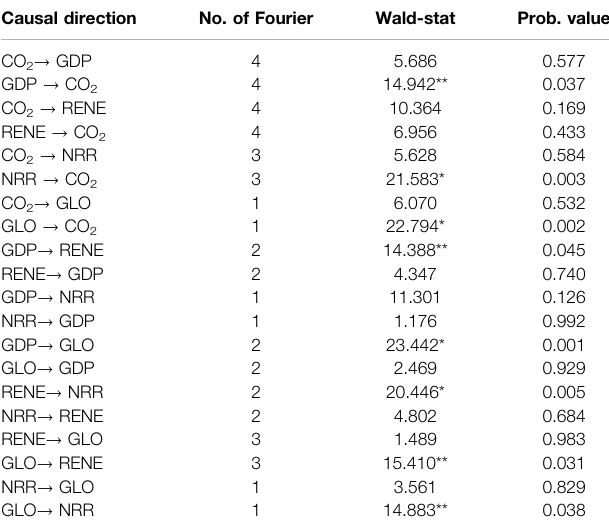
TABLE 7 | Gradual shift causality